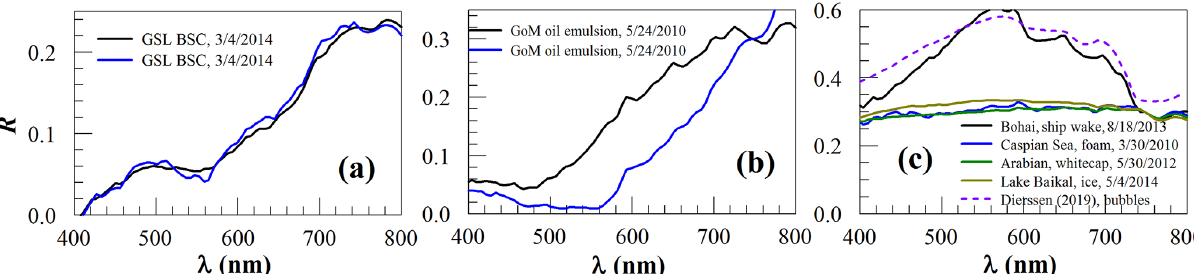
Figure 4. Surface reflectance ( R , dimensionless) of various floating materials: (a) brine shrimp cysts in the Great Salt Lake (GSL BSC); (b) emulsified oil from the Deepwater Horizon oil spill in the Gulf of Mexico (GoM); and (c) ship wake, sea-foam, whitecaps, and ice. The dashed line in (c) denotes submersed bubbles measured by Dierssen (2019), which is similar to the ship wake spectrum. Note the similarity among other spectra.